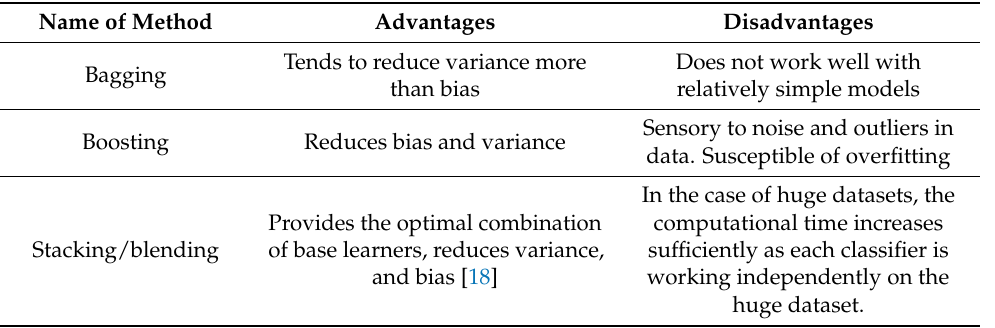
Table 1. Comparison of ensemble techniques. Name of Method Advantages